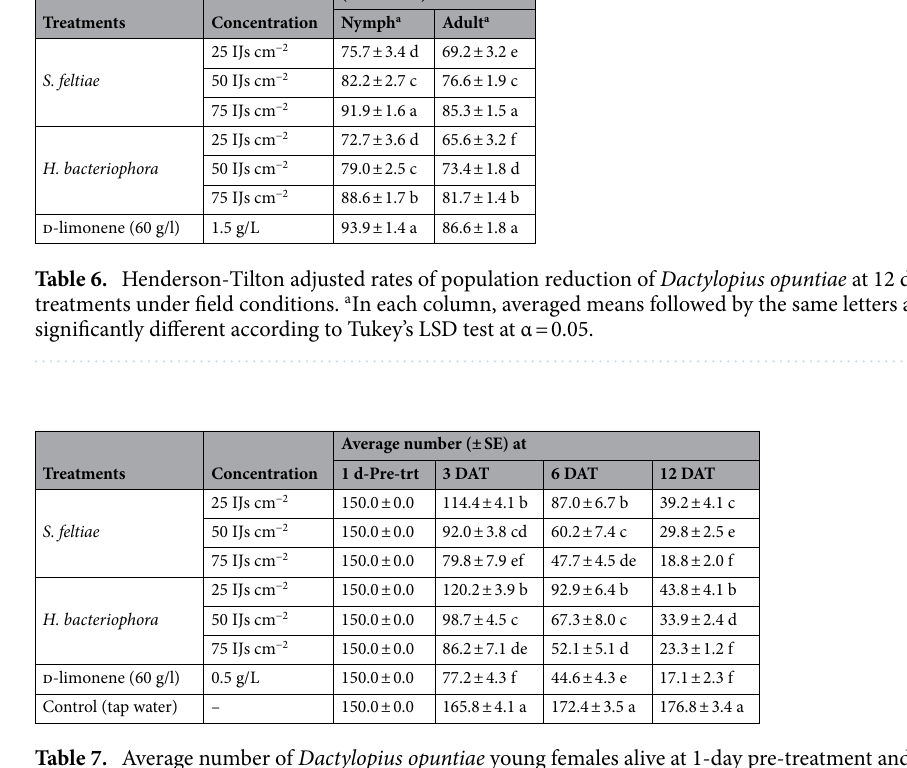
Table 7. Average number of Dactylopius opuntiae young females alive at 1-day pre-treatment and 3, 6, and 12 days after been exposed to S. feltiae , H. bacteriophora , and d-limonene (60 g/l) (DAT), or tap water under field conditions. In each column, averaged means followed by the same letters are not significantly different according to Tukey’s LSD test at α = 0.05.